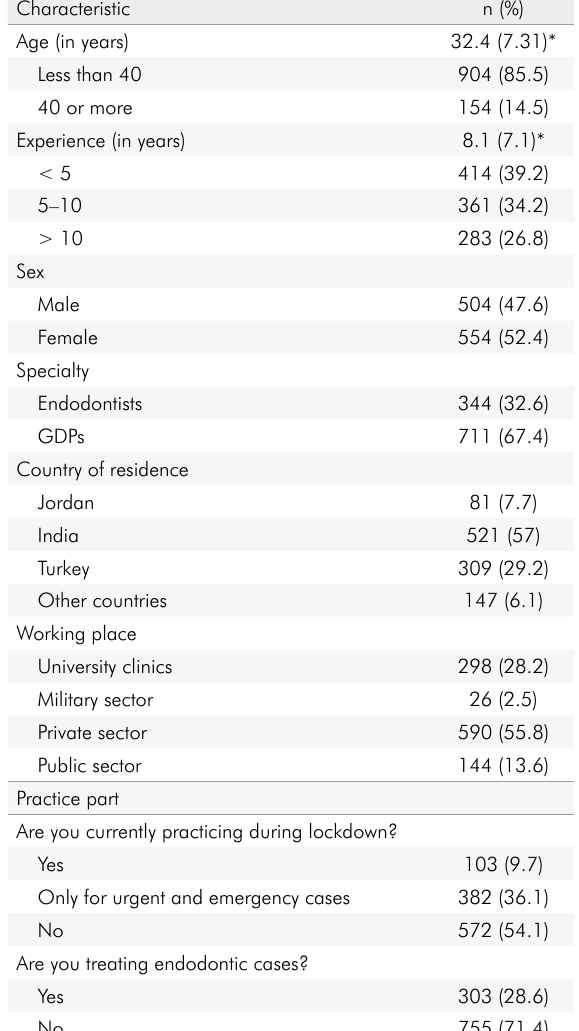
Table 1. Personal and professional data on the clinicians’ age, sex, education, current work status, and experience. (n =